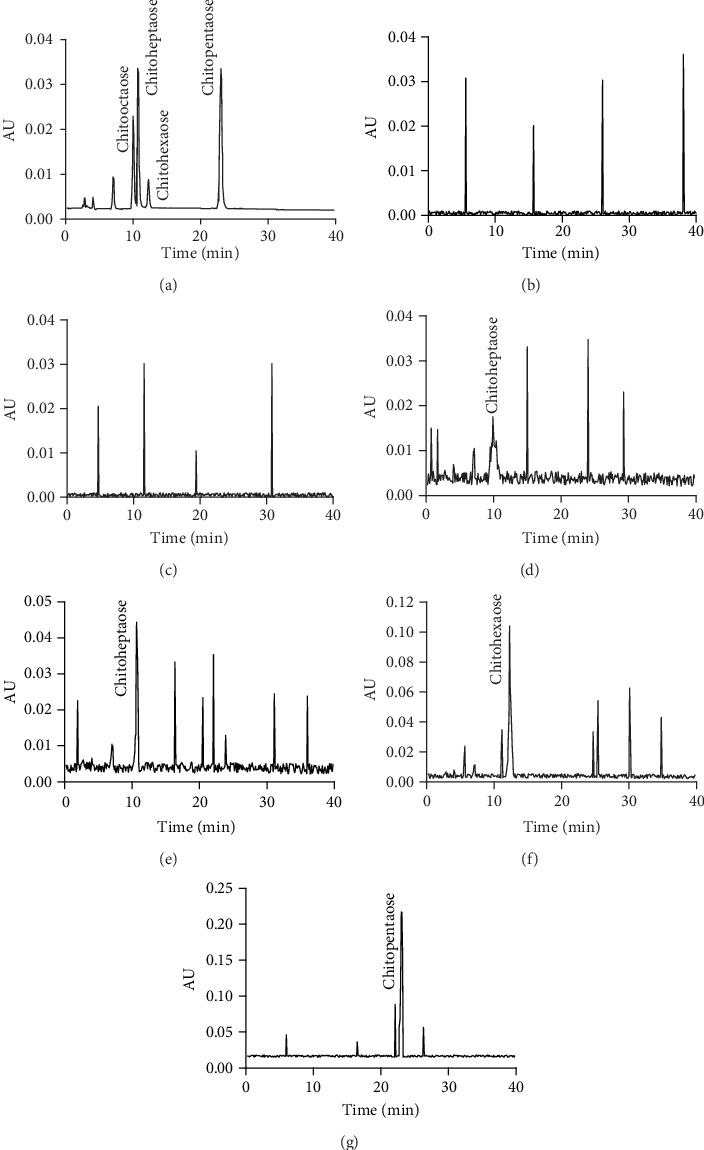
HPLC analysis of blood chitosan oligosaccharides. (a) Standard of chitosan oligosaccharides. (b) Control group. (c) Model group. (d) Chitopentaose. (e) Chitohexaose. (f) Chitoheptaose. (g) Chitooctaose.